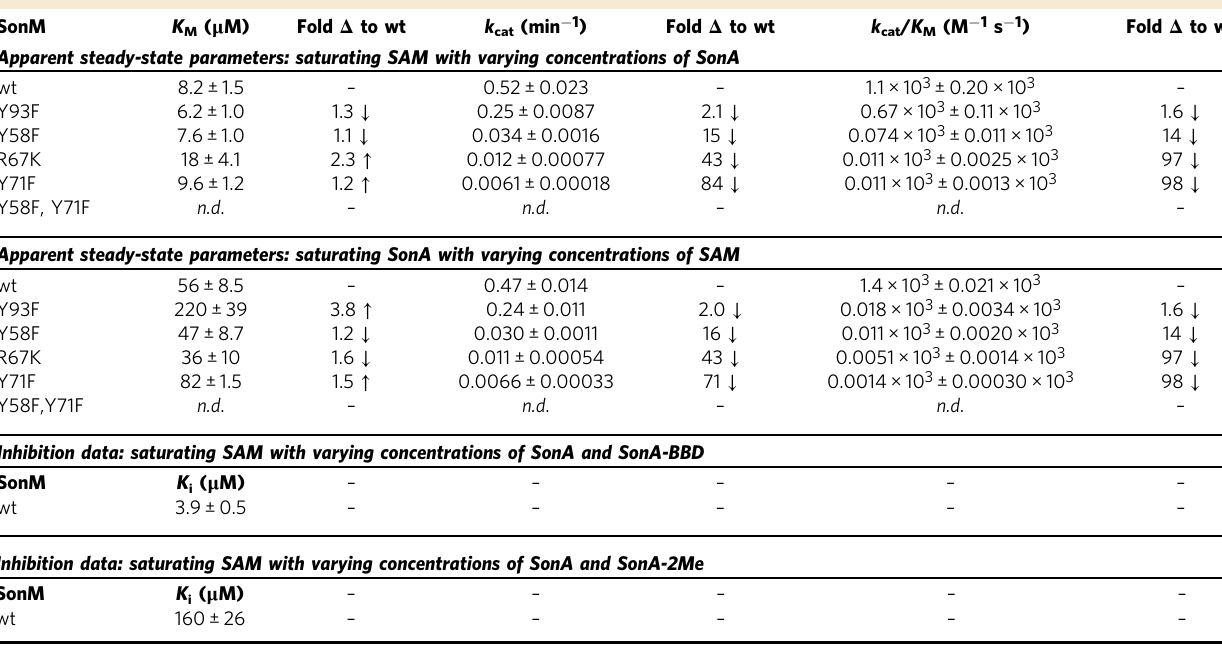
Table 1 Apparent steady-state kinetic